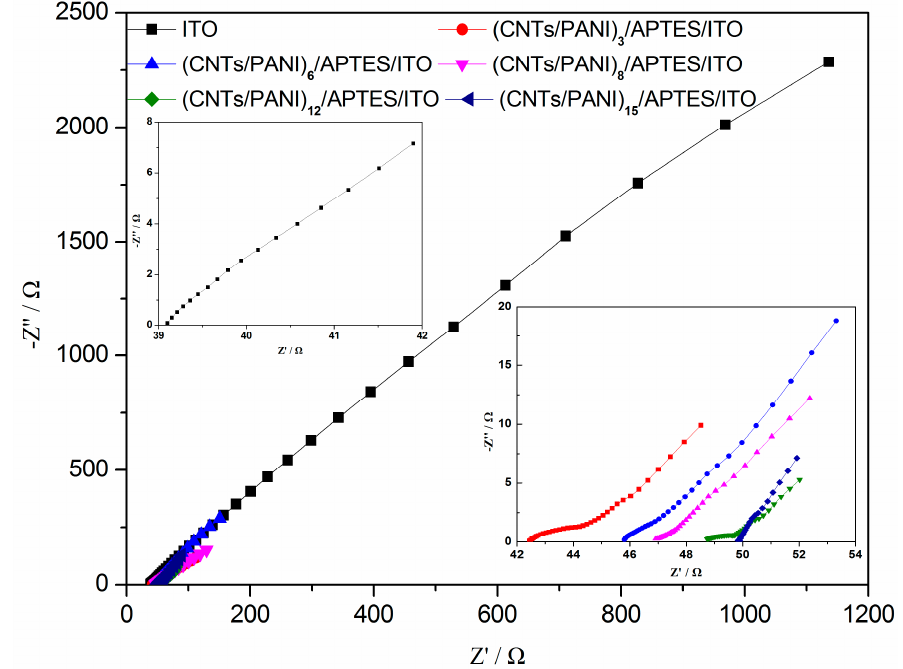
Figure 5. Nyquist plots on ITO electrode and (CNTs/PANI) n /APTES/ITO after 25 h of chronoamperometry (0.1–100 kHz at open-circuit potential and with a perturbation signal of 10 mV). The inset is the higher magnification of the high frequencies part. n = 3, 6, 8, 12 and 15.